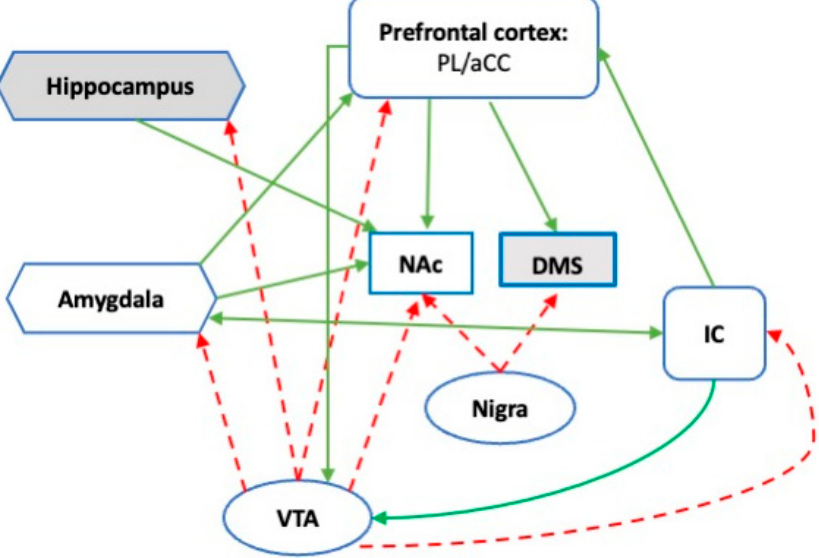
Figure 1. Schematic representation of the mesocorticolimbic DA system associated with stress coping. Dotted lines indicate DA afferences; solid lines indicate functional connectivity; white-filled areas are part of the SN in humans and rodents [53]. PL prelimbic cortex; aCC: Anterior cingulate cortex; IC: Insula cortex; NAc: Nucleus accumbens/ventral striatum; DMS: Dorsomedial striatum; Nigra: Substantia nigra pars compacta; VTA: Ventral tegmental area.